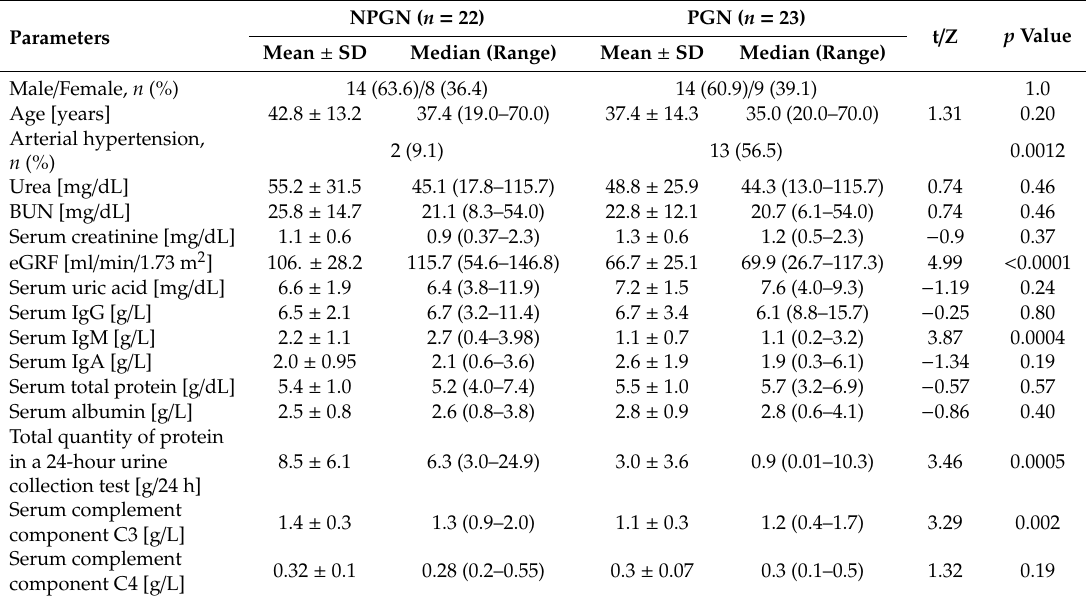
Table 2. Basic characteristics of NPGN and PGN